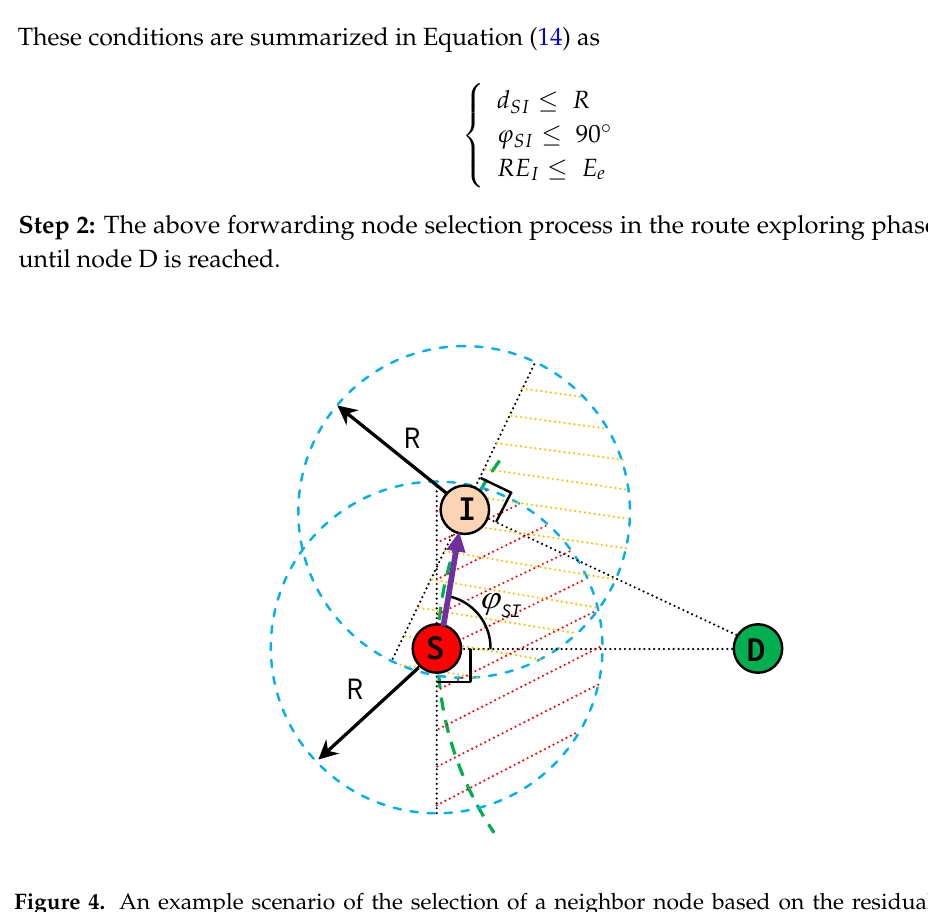
Figure 4. An example scenario of the selection of a neighbor node based on the residual battery, energy harvesting, and location information in the proposed stability-aware geographic routing in energy-harvesting wireless sensor network (SAGREH) routing